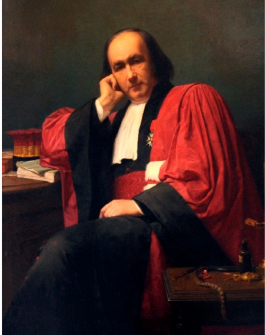
Figure 1. Claude Bernard in 1861 in his dress of a professor of the Faculty of Sciences.